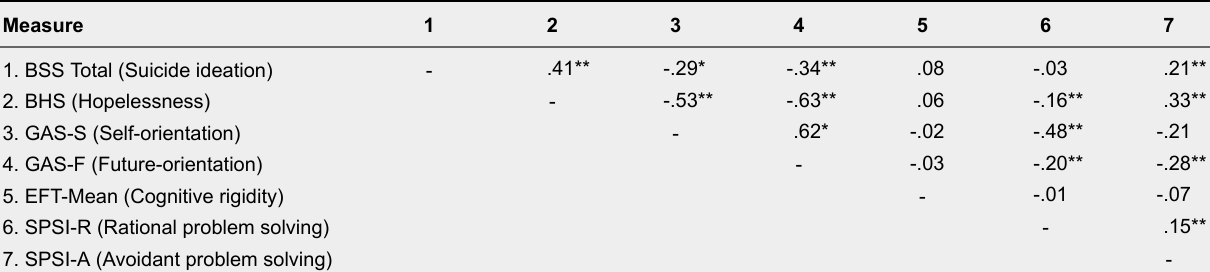
Correlation Matrix of all Measures in the Hypothesized Model